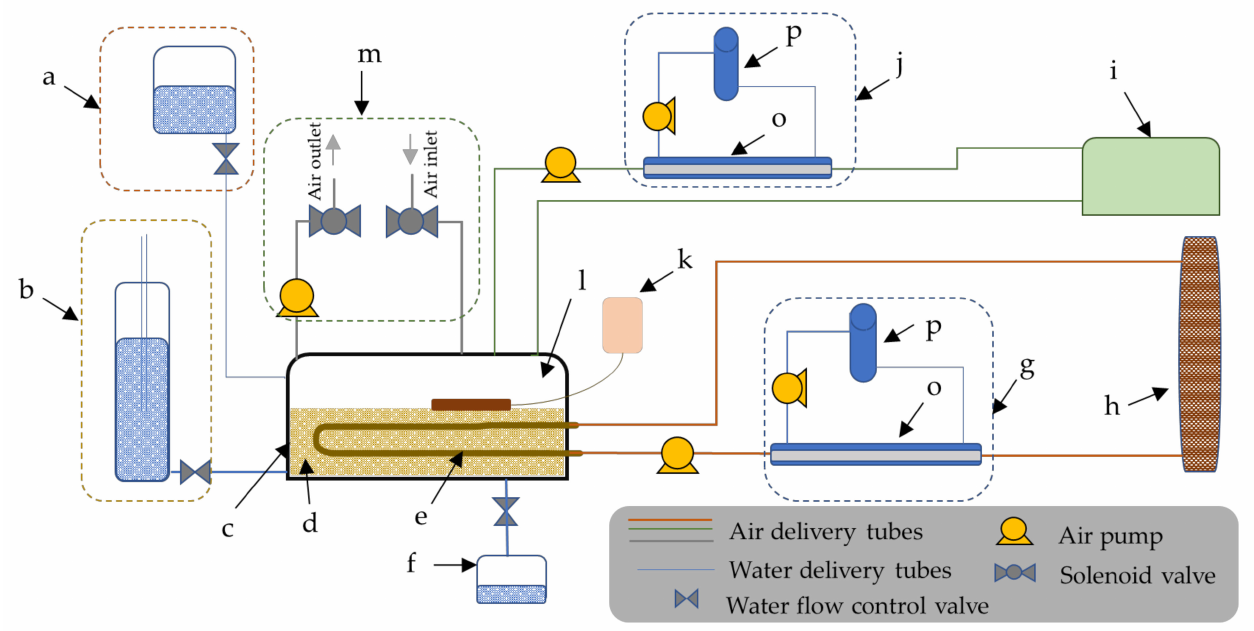
Figure 3. A diagram of the laboratory experimental setup for monitoring variations in the headspace and soil atmospheric N 2 O gas concentrations: ( a ) top-side water supply unit, ( b ) bottom-side wa- ter supply unit (Mariotte cell), ( c ) soil chamber, ( d ) soil region, ( e ) diffusion cell (silicone tube), ( f ) water drainage system, ( g , j ) membrane air-drying system, ( h ) low-cost NDIR gas-monitoring device, ( i ) FTIR device, ( k ) data logger connected to soil moisture and temperature